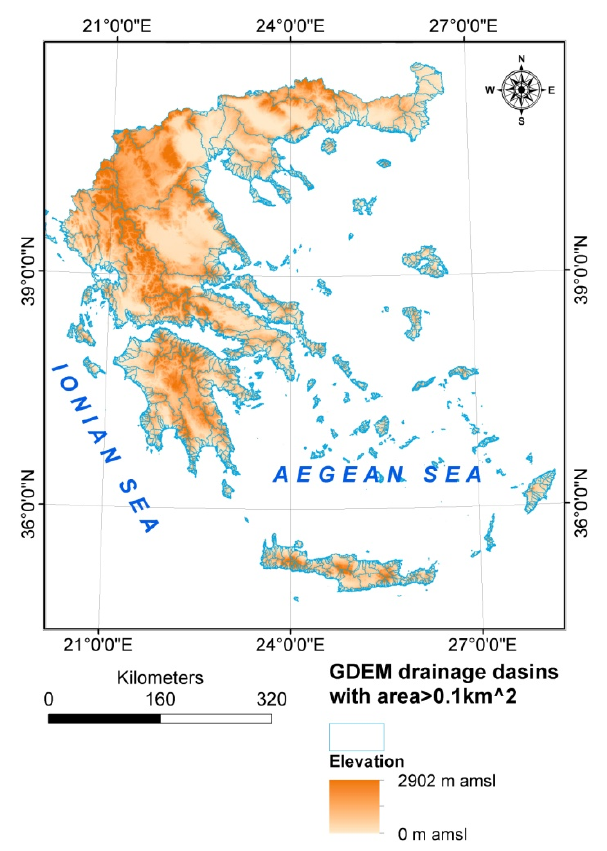
Figure 1. The ASTER GDEM of Greece with drainage basins polygonal data overlay.